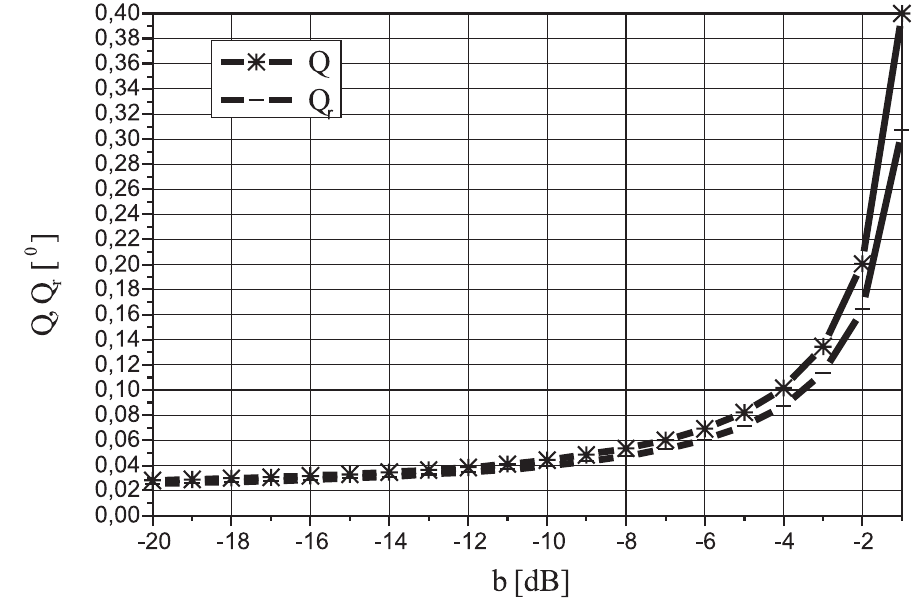
snaga signala ometanja menja položaj ekvisignalnog pravca. Ova osobi- na koristi se kao efikasno sredsvo za borbu protiv sistema sa metodom navo đ enja proporcionalnim približavanjem. Na slici 9 date su uporedne vrednosti ugla ekvisignalnog pravca za slu č ajeve kada je eho signal prisutan i kada ga nema.